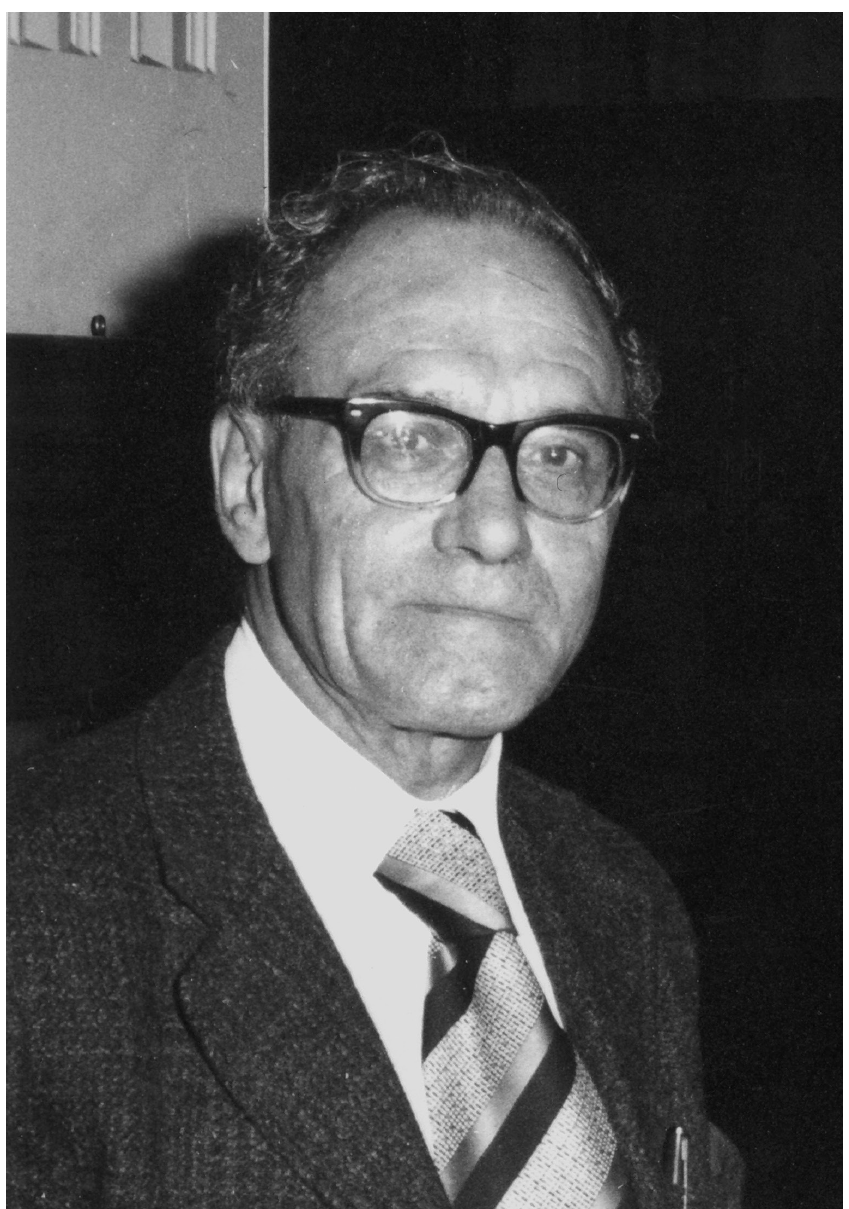
Fig. 10. Alan Brindle (1915–2001), Keeper of Entomology at the Manchester Museum (1961–1982), photographed in the mid